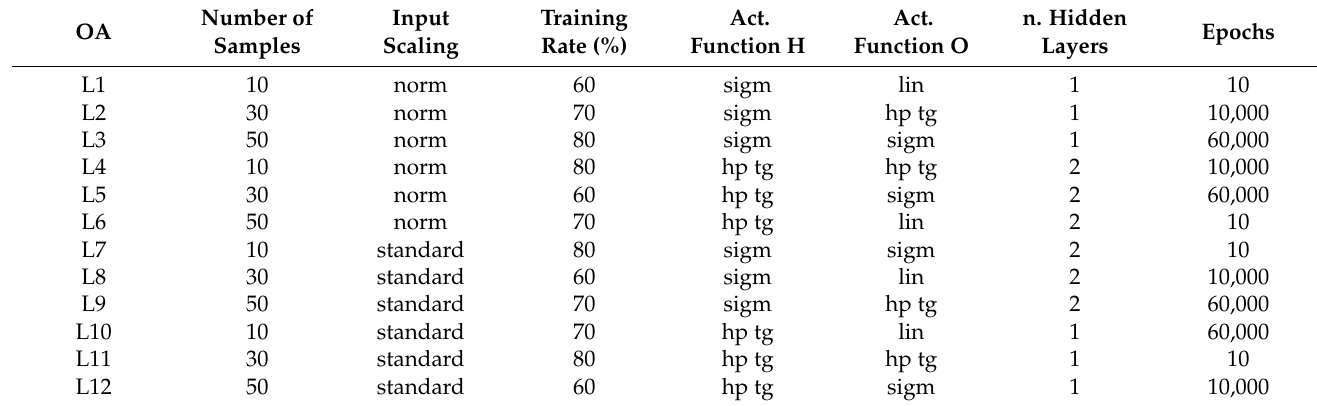
Table 3. Orthogonal array (OA) of Taguchi design L12.